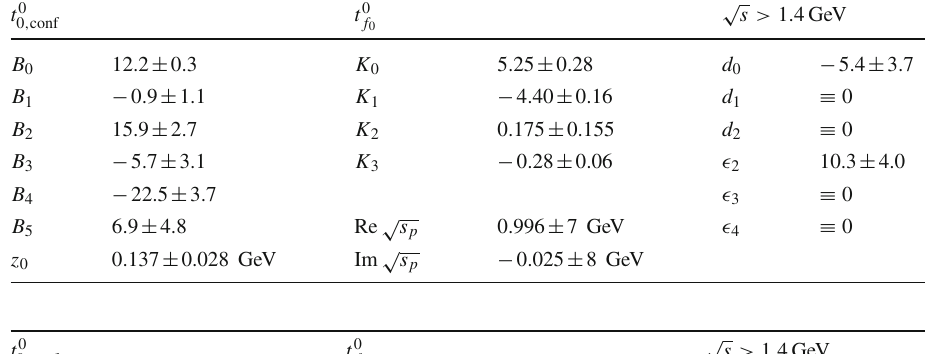
Table 2 Fit parameters of the global parameterization for the S 0-wave solution II. s p is the f 0 ( 980 ) pole position from the dispersive analysis in [36]